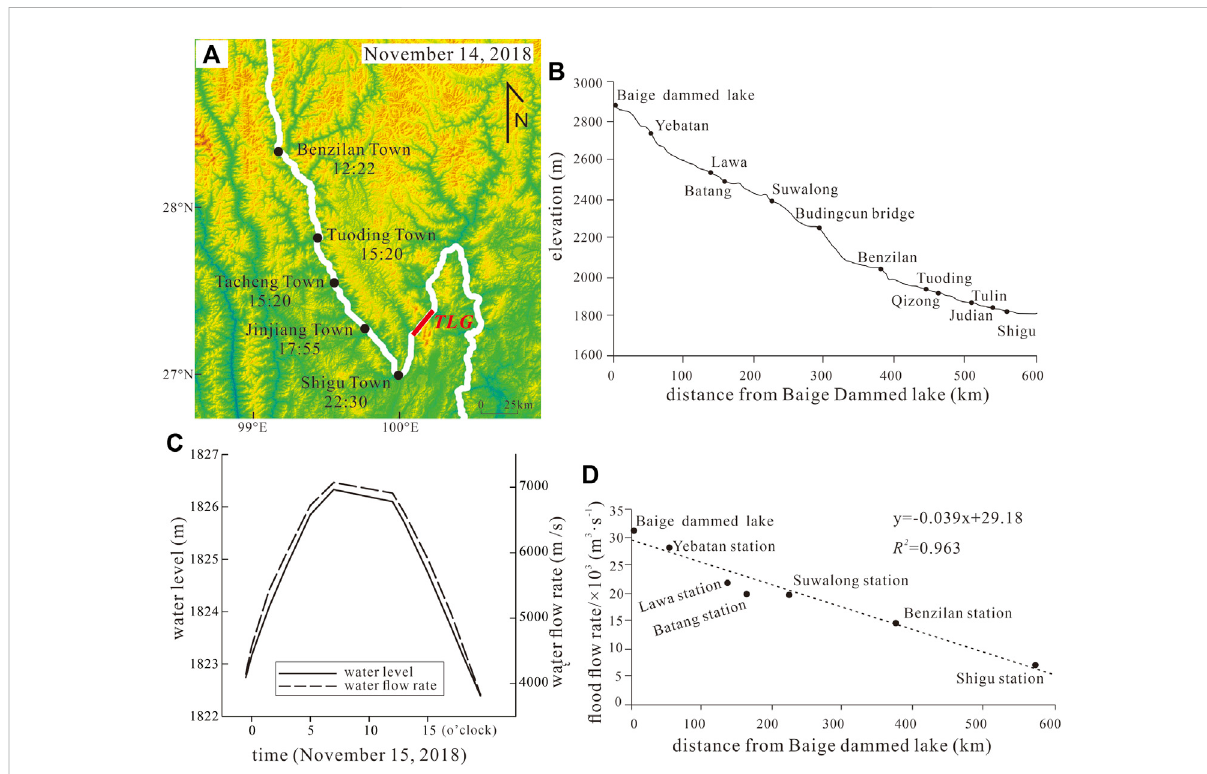
FIGURE 3 (A) Stepped discharge timeofdiluvium fromtheBaige dammedlake. (B) Riverbedpro fi leoftheJinshaRiverfromtheBaigedammedlaketothe Shigu area. (C) Water level and water fl ow rate of the Jinsha River in the Shigu area on 15 November 2018 (data from the Bureau of Hydrology, Changjiang Water Resources Commission). Discharge from the Baige dammed lake began at 18:30 h on 13 November 2018 and reached the Shigu area at 22:30 h on 14 November 2018. (D) Rate of fl ood fl ow from the Baige dammed lake to the Shigu area. (B,D) Cited from Su et al. (2021). TLG: Tiger Leaping